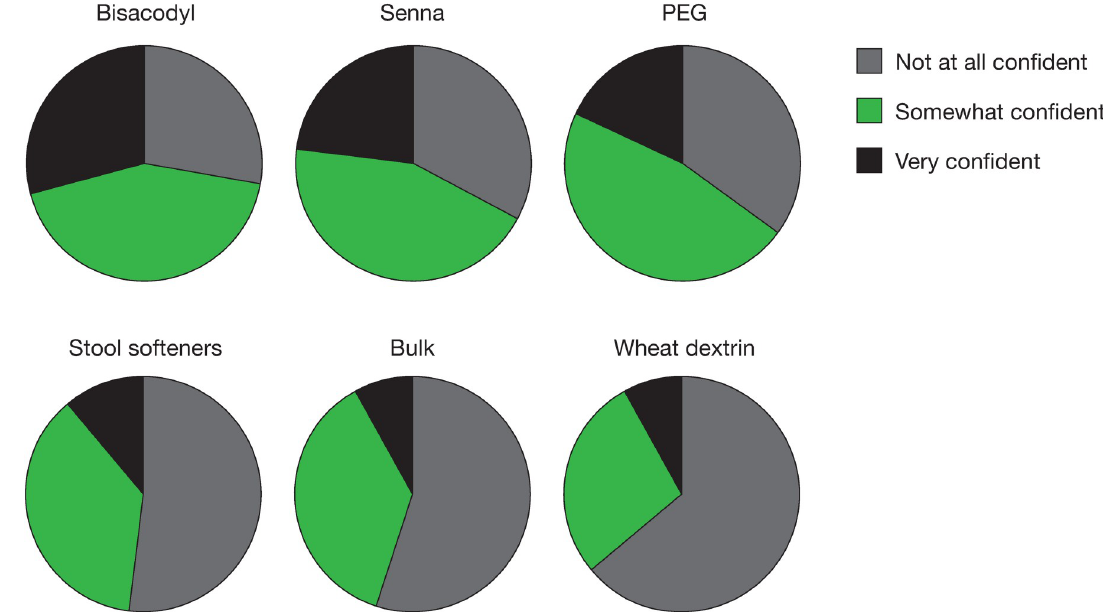
Fig 4. Patient confidence in predicting the timing of bowel movements after taking an OTC medication. Abbreviations: OTC = over-the-counter, PEG = polyethylene glycol.